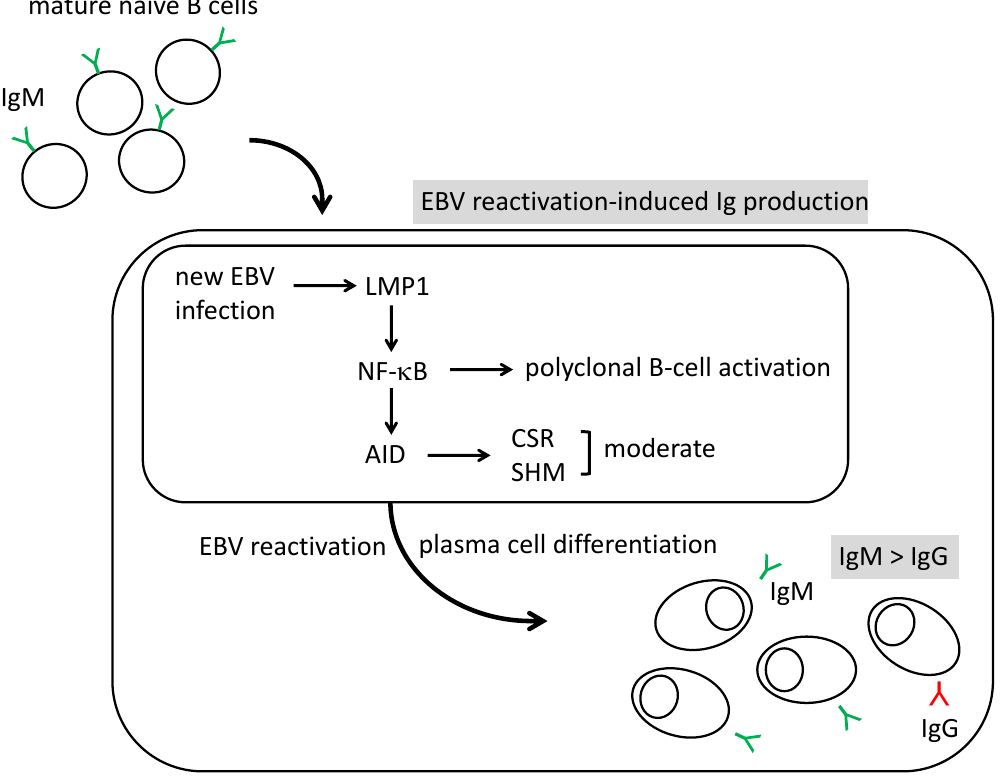
Figure 2. IgM dominant production induced by EBV reactivation. In EBV reactivation-induced Ig production, newly infected EBV induces LMP1 and then stimulates NF- κ B to activate polyclonal B cells. NF- κ B binds to the promoter of the AID gene (AICDA) to stimulate AID production. Class-switch recombination (CSR) and somatic hypermutation (SHM) may be catalyzed, but are moderate. Therefore, the Ig produced are